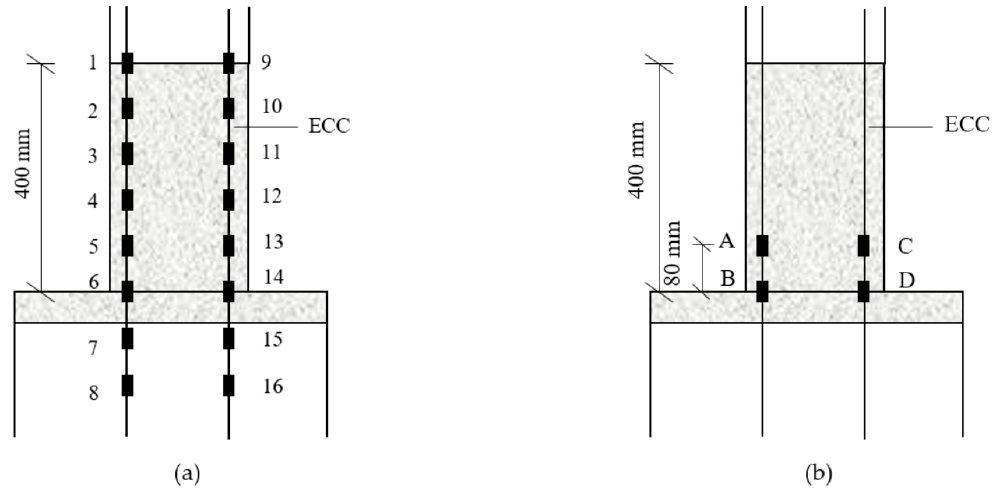
Figure 5. Arrangement of strain gauges on: ( a ) steel bars and ( b ) GFRP bars.